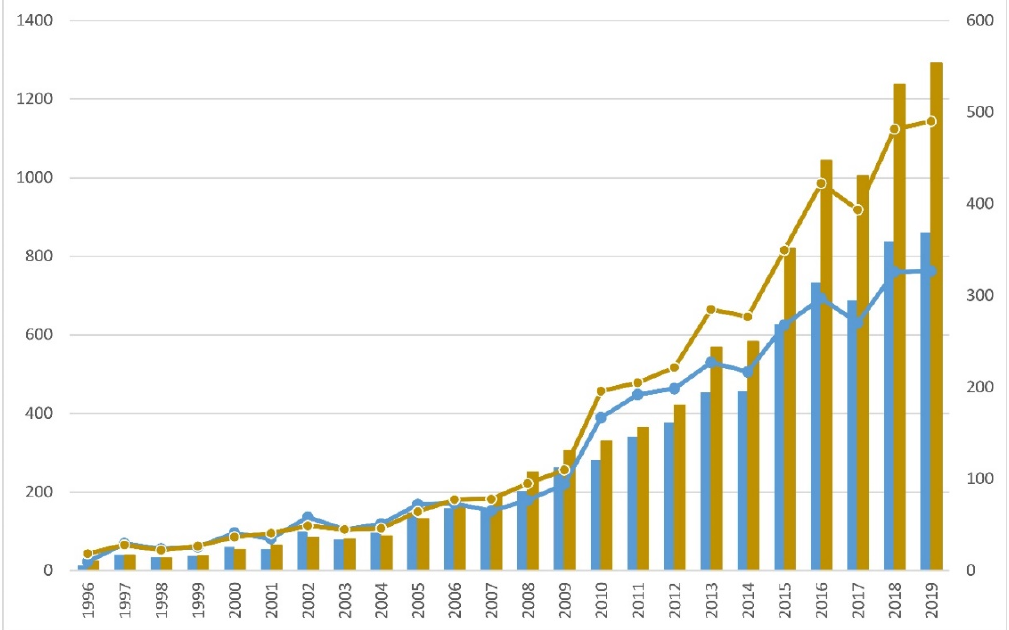
Figure 2. Bar chart showing the number of FRA references (brown bars, FRAn; blue bars, FRAs; records in left axis) in WoS databases classified by ‘Publication years’, for the last quarter century (1996–2019); dots and lines correspond to the rate per million of FRA records with respect to the total from the WoS database (brown ones, FRAn; blue bars, FRAs; right axis). The sharp jump between 2009 and 2010 must correspond to a change in the WoS database registration system.